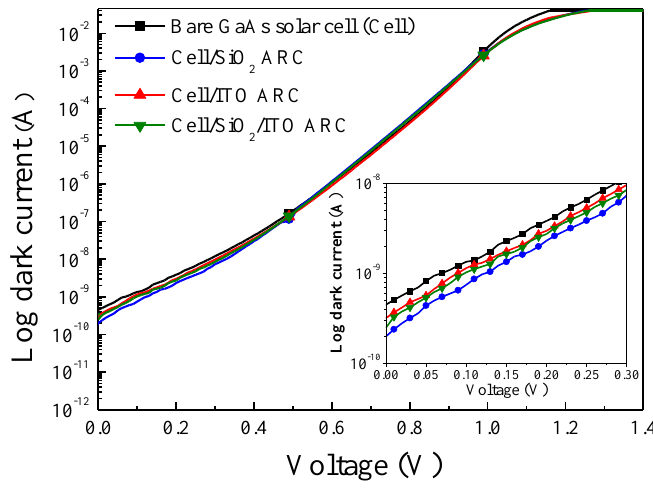
Figure 4. Dark I-V curves of bare GaAs solar cell, GaAs cell with SiO 2 ARC, GaAs cell with ITO ARC, and cell with thin-SiO 2 /ITO ARC.